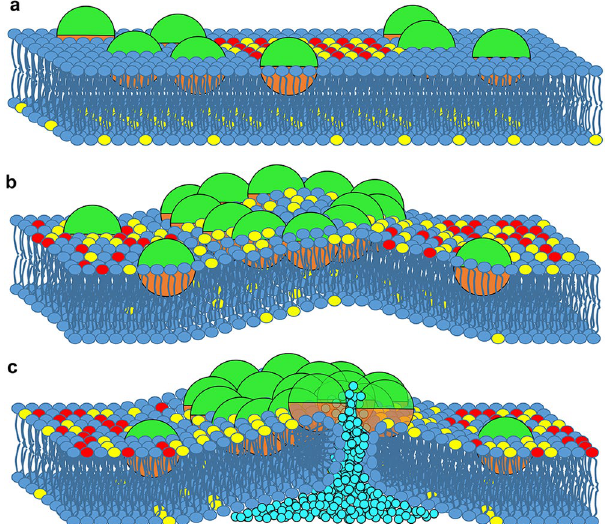
Figure 6. Overview of the membrane disruption mechanism of kB1. ( a ) The hydrophobic surface (orange) initiates and stabilizes the binding of kB1 to the membrane, while the hydrophilic surface (green) interacts with the lipid polar heads and water. The kB1 molecules prefer binding to the ld domain. ( b ) The asymmetric membrane binding of kB1 induces lipid lifting. The lipids are lifted the highest inside the kB1 ring-like hollow. The deformation in the outer layer consequently induces lifting of the lipids in the inner layer. The kB1 molecules disorganize the lo domain and cause the translocation of CHOL from the inner layer to the outer layer. ( c ) The perturbation and extraction make a defect area where lipid molecules are loosely packed, which allows the permeation of water molecules (light blue color) into the bilayer. The fusion between the outer and inner layers responding to the permeation of water eventually causes the membrane pore to form a volcano- like shape. The water molecules leak from the inner layer side to the outer layer side by diffusing inside the kB1 cluster that covers the volcano crater. The head groups of DPPC, DLiPC, and CHOL are shown in red, blue and yellow,